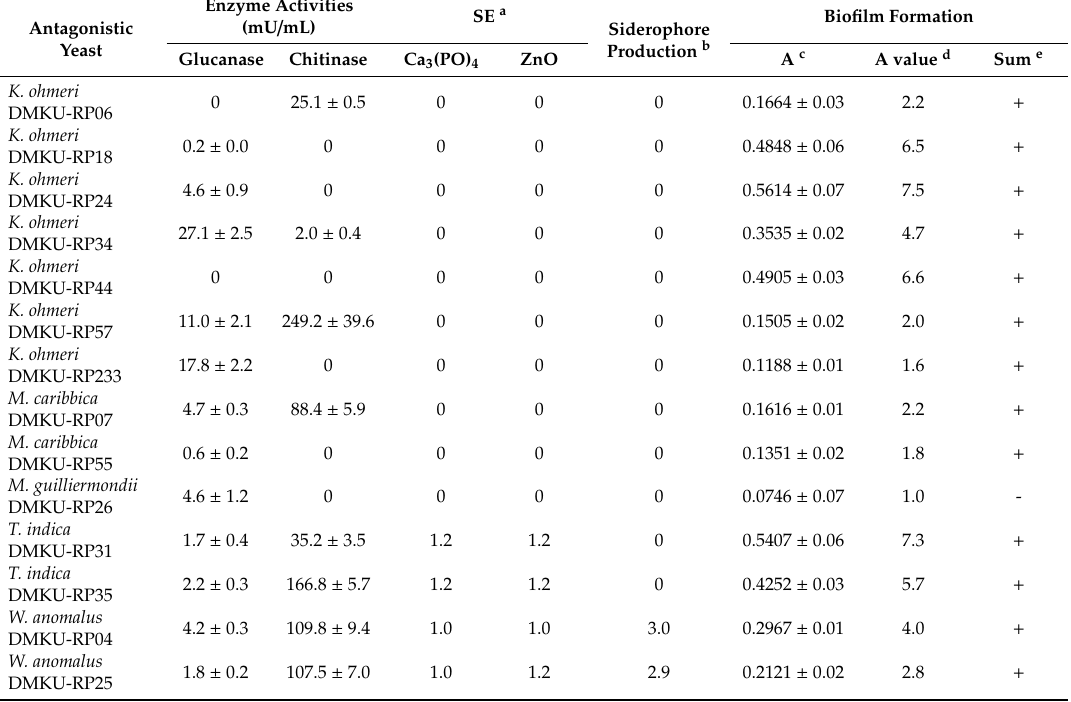
Table 6. Production of β -glucanase and chitinase, phosphate and zinc oxide solubilization, siderophore production, and biofilm formation of the antagonistic